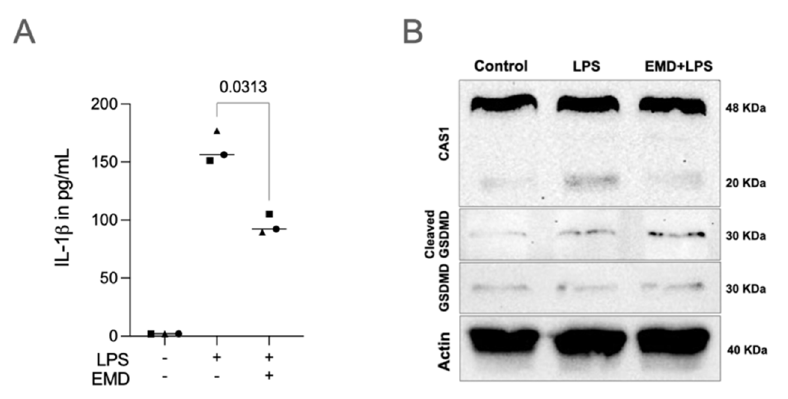
Figure 4. EMD reduces the pyroptosis factors in LPS-induced RAW 264.7 macrophages . ( A ) EMD protection on LPS-stimulated RAW 264.7 macrophages led to IL-1 β reduction detected from the immunoassay. Different symbol shapes mean independent experiments. Paired t -test to compare LPS and EMD + LPS groups was applied. ( B ) Confirming the gene expression, Western blot analyses showed less cleaved CAS1 (20 KDa) protein expression in RAW 264.7 cells primed with EMD. Cleaved GSDMD was present in cells stimulated with LPS and GSDMD was present in all groups.